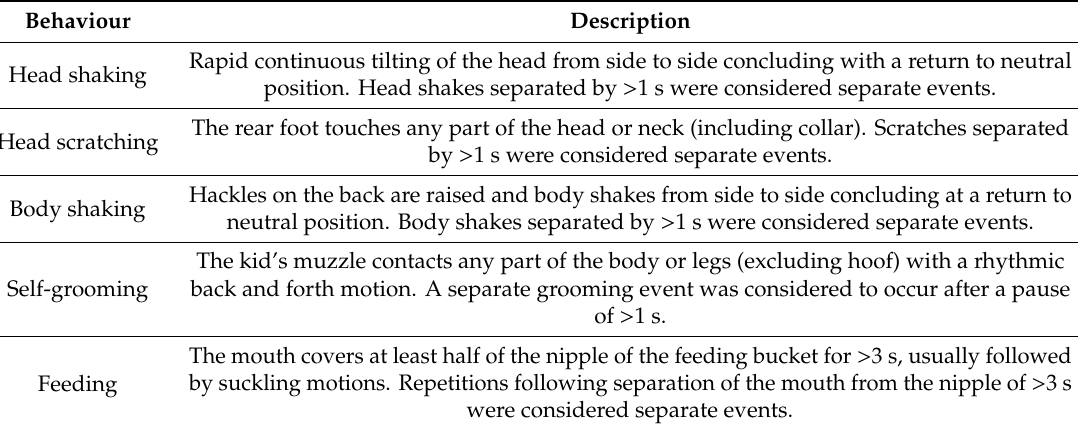
Table 1. Ethogram of behaviours quantified in the present study. Modified from Hempstead et al. [9]. Behaviour